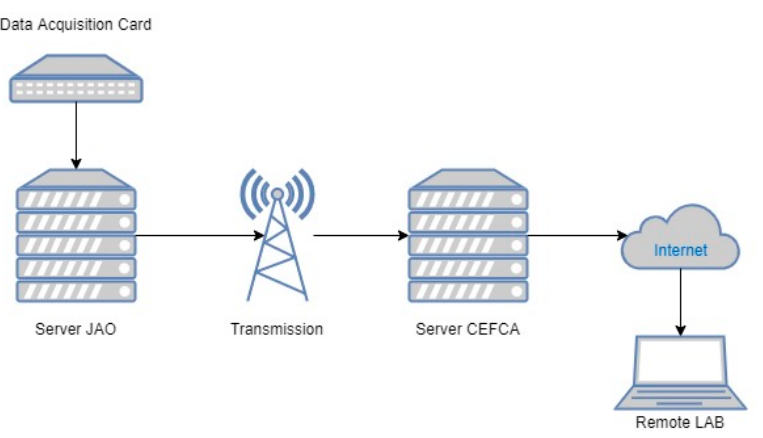
Figure 3. Communication scheme between JAO-CEFCA and a remote laboratory.